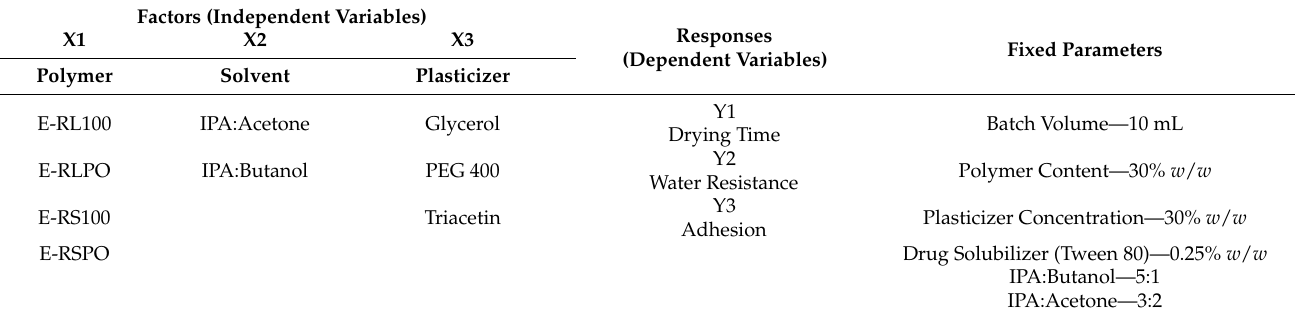
Table 2. Levels of chosen material attributes (X1, X2 and X3) and responses measured (Y1, Y2 and Y3) as well as parameters fixed for the secondary experimental